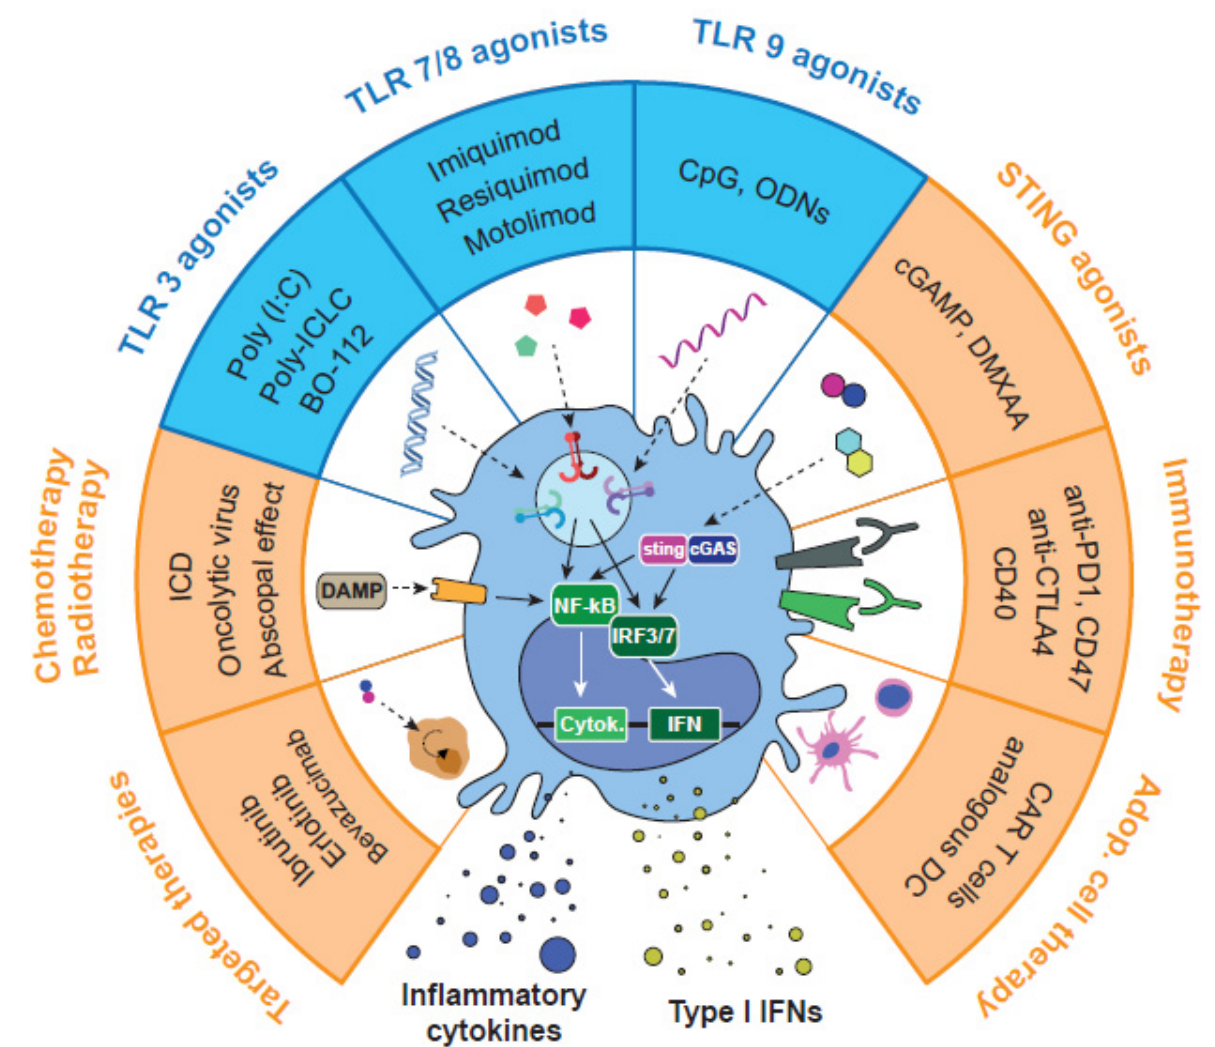
Figure 3. Pharmacological strategies for the activation of endosomal TLRs and combinations with other therapeutic approaches. TLR ag alone or in combination have demonstrated the ability to reprogram TAMs towards M1-like antitumor macrophages. This pharmacological approach has been tested in preclinical and clinical studies with other immunotherapies, such as STING agonists, immune checkpoint inhibitors, or adoptive cell therapy. Other combinations include chemotherapy, oncolytic viruses, or radiotherapy, which can kill cancer cells and trigger immunostimulatory re- sponses. Finally, some studies have used combinations with targeted therapy, epigenetic drugs, or metabolic reprogramming drugs.